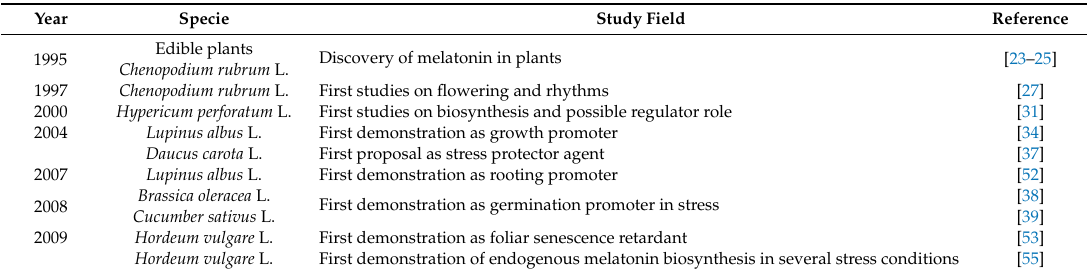
Table 1. Most relevant studies on melatonin in plants in the period